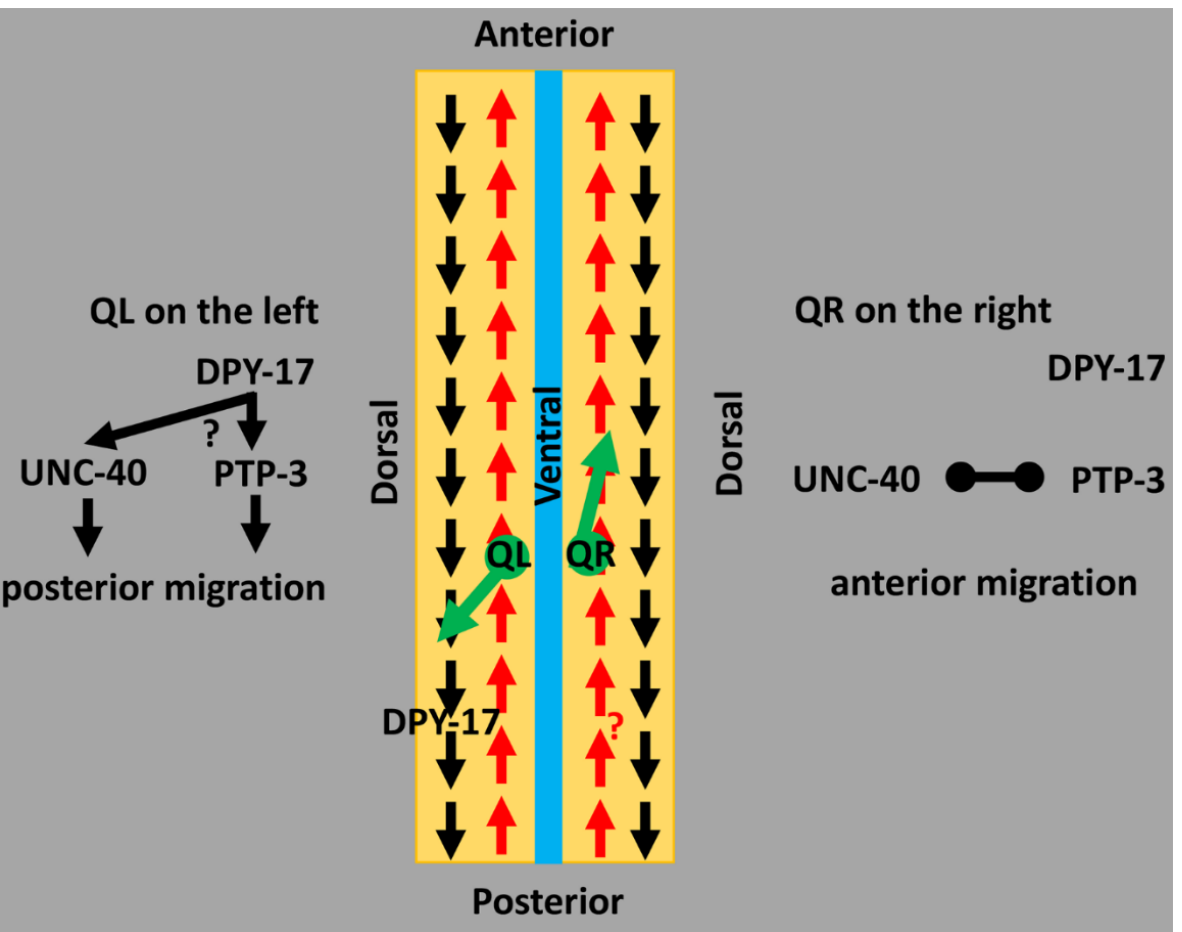
Figure 3. A model of DPY-17 and SQT-3 collagens in directed neuroblast migration. A schematic representation of an animal that has been cut along the dorsal axis and splayed open. Arrows represent a potential asymmetry in the extracellular matrix involving collagens (i.e., a pattern in the extracellular matrix (ECM) oriented to the anterior–posterior axis of the animal). The black “posterior” pattern might be defined by DPY-17 and SQT-3. In QL, this pattern is used for posterior migration. An unidentified red “anterior” pattern might be followed by QR for anterior migration. The inherent L/R asymmetry in the Q neuroblasts, possibly involving UNC-40/DCC and PTP-3/LAR receptor functions, might determine the response of the Q neuroblasts to these ECM patterns. In QL, DPY-17 might instruct UNC-40 and PTP-3 to migrate to the posterior. In QR, UNC-40 and PTP-3 inhibit one another, allowing for the “anterior” pattern to be